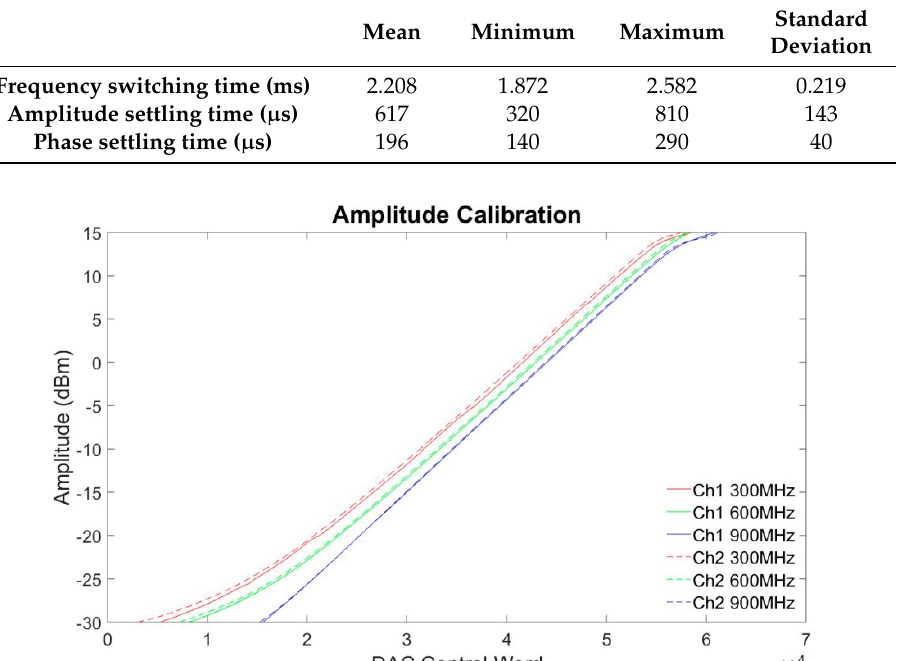
Table 1. Test results of the switching / settling times for frequency, amplitude and phase.